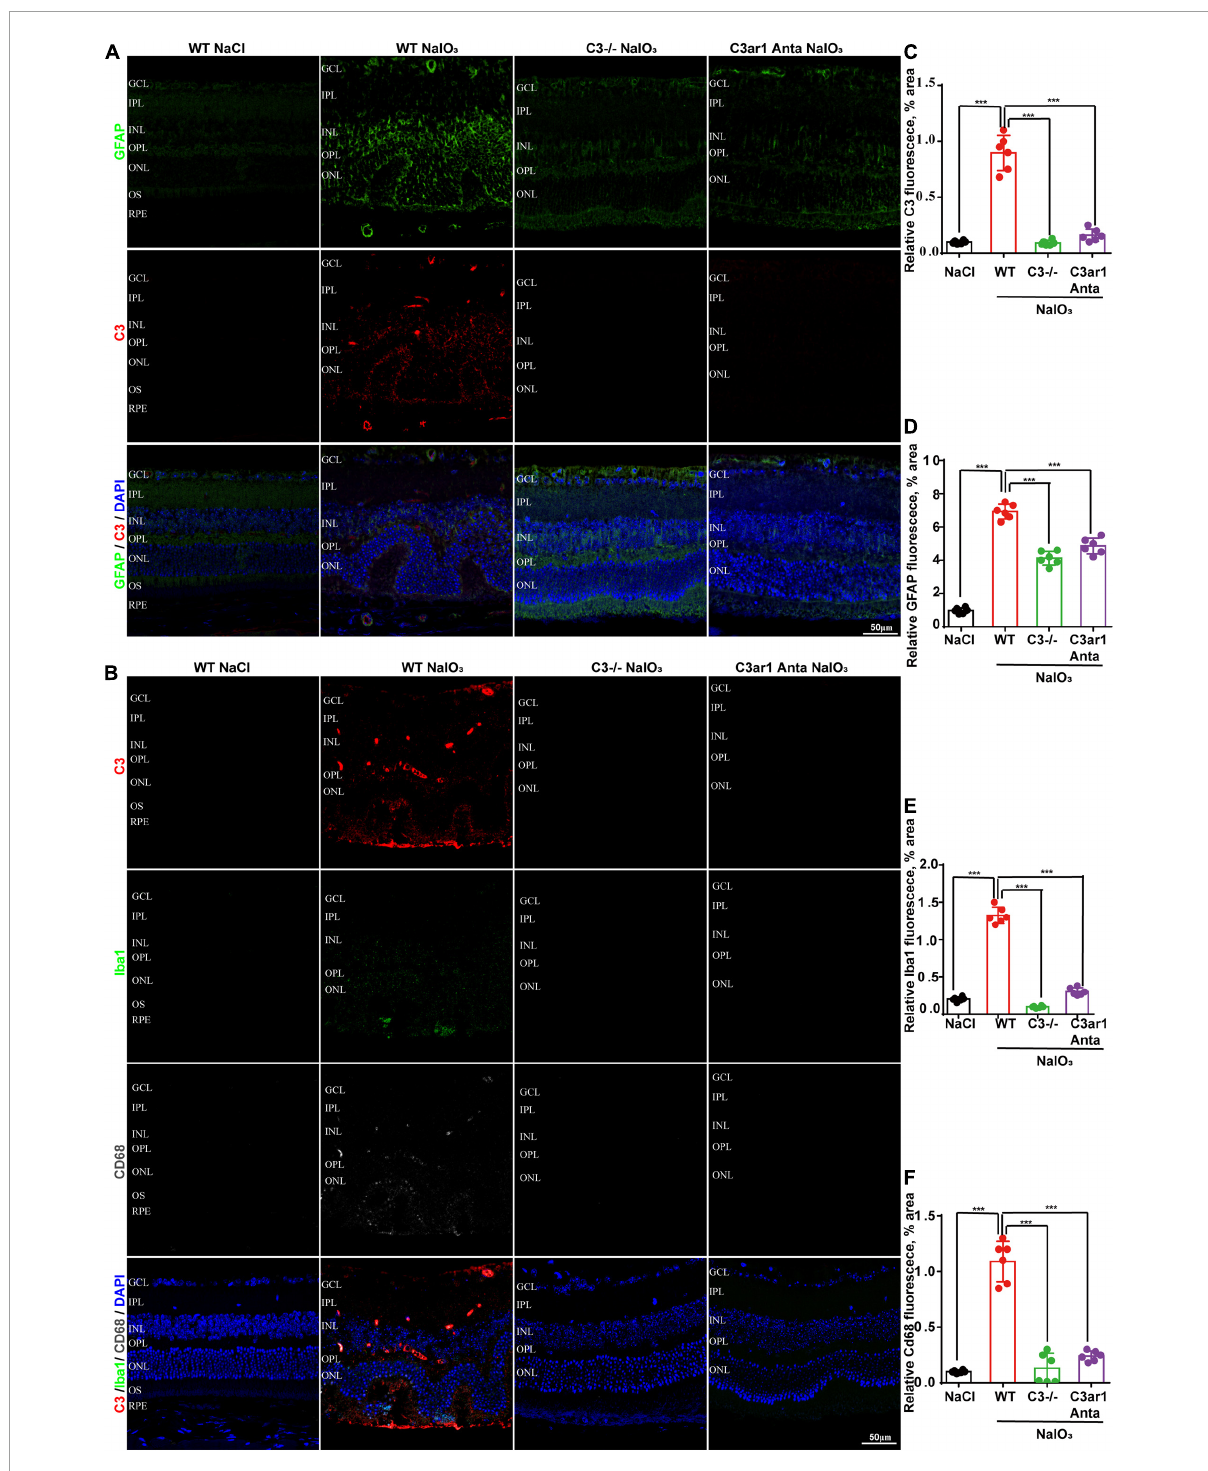
FIGURE3 Genetic deletion of C3 and inactivation of C3ar1 attenuate reactive gliosis and microglial infiltration. (A) Representative GFAP and C3 multicolor immunofluorescence staining in the retinas of saline control- and NaIO3-treated WT, C3-KO and C3ar1-inhibited mice. Scale bar: 50 mm. (B) Representative C3, Iba1 and CD68 multicolor immunofluorescence staining in the retinas of saline control- and NaIO3-treated WT, C3-KO and C3ar1-inhibited mice. Scale bar: 50 mm. (C–F) Quantification of C3, GFAP, Iba1 and CD68 immunoreactivities. The data represent the mean ± SEM, n = 6. *** p <